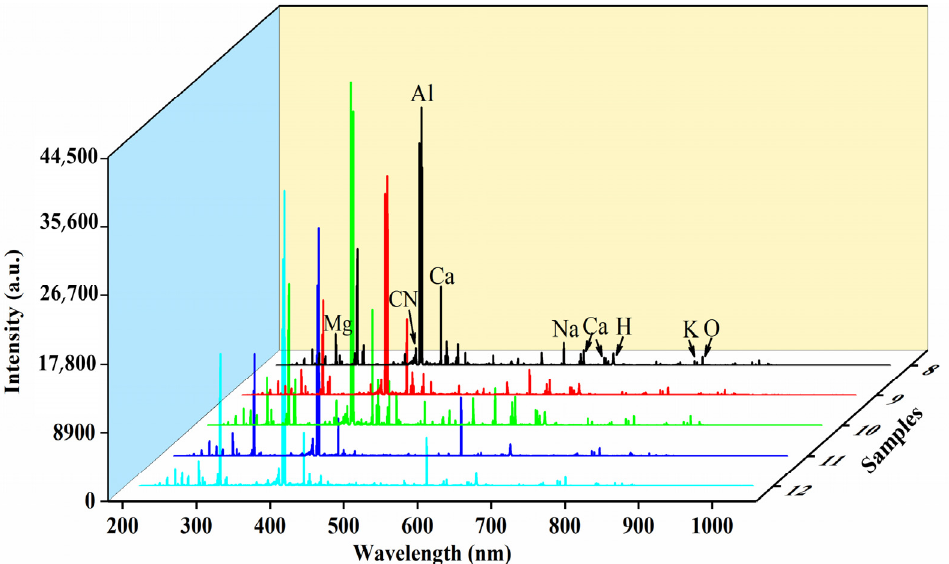
Figure 9. Average LIBS spectra for three real soil samples (samples 8–10) from the China National Rice Research Institute and two soil standard substances, GBW07456 (sample 11) and GBW070046 Table 2. The analytical results of real soil samples obtained by the REMC-LIBS and CNS